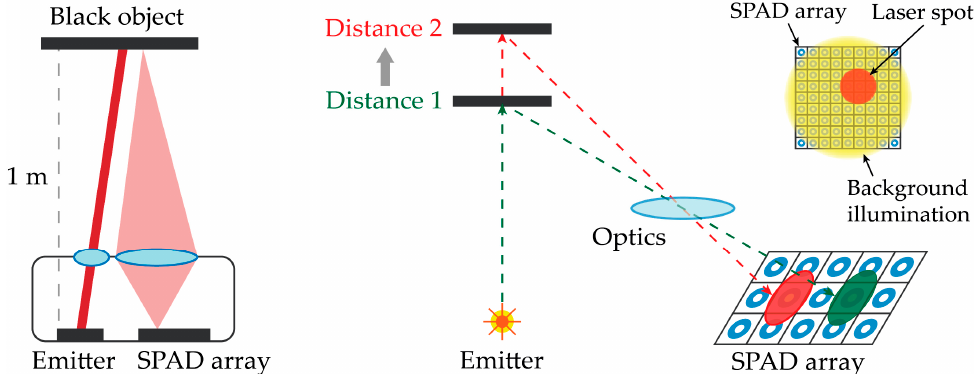
Figure 3. Optical setup with SPAD array and laser emitter ( left ) and the effect of the object variable distance on the actual position of the laser spot on the detector ( right ).